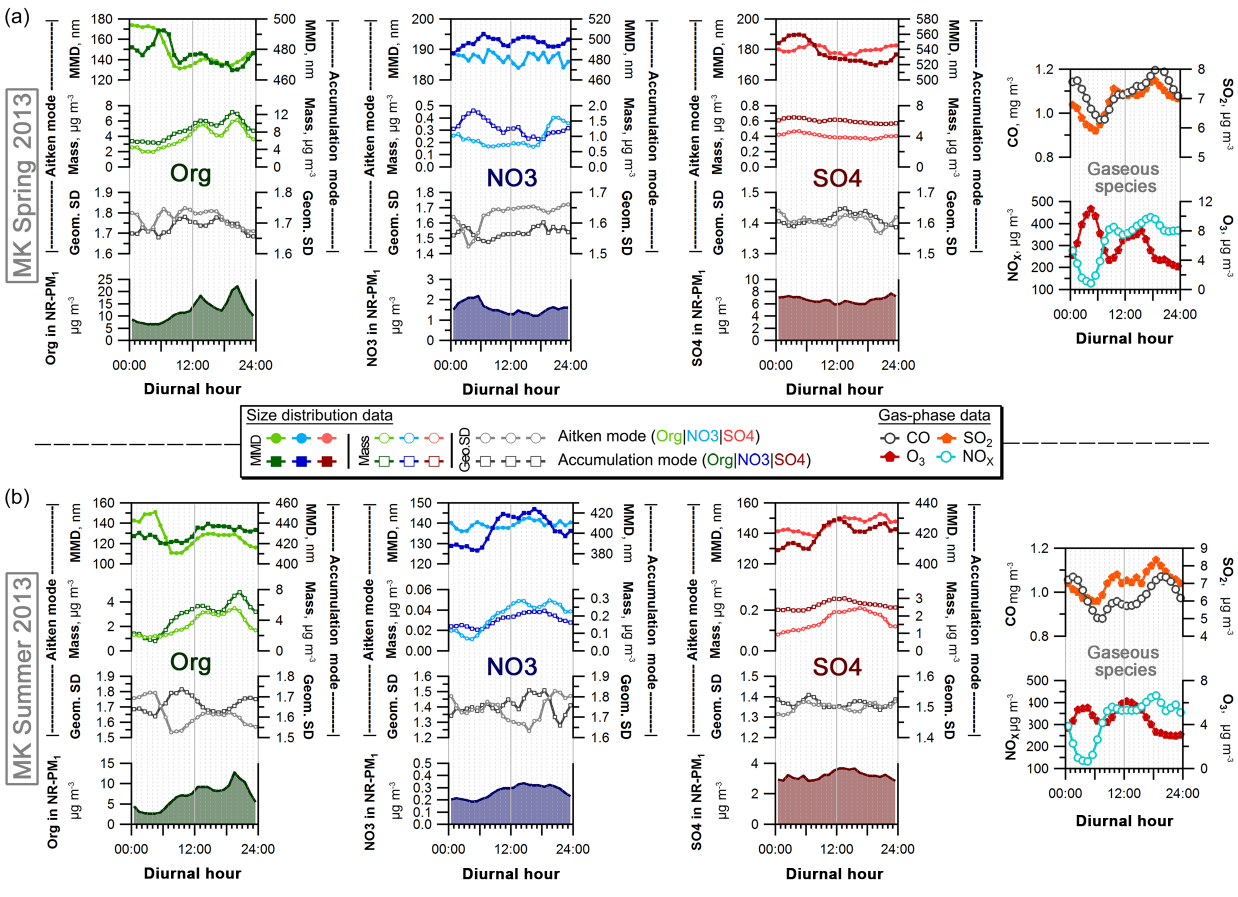
Figure 2. Diurnal variations in mode diameter (MMD), integrated-mode mass concentration, and width of the Aitken mode (lighter color) and accumulation mode (darker color) from bimodal peak fits of the bin-median reconstructed size distributions at the urban Mong Kok site, as well as V-mode AMS species concentrations (line with shaded background) for organics, nitrate, and sulfate (left to right) in (a) spring 2013 and (b) summer 2013. The right-most panels depict the median diurnal variations in relevant gas-phase pollutants (O 3 , CO, NO x , SO 2 ) measured at the adjacent Mong Kok Air Quality Monitoring Site (MK